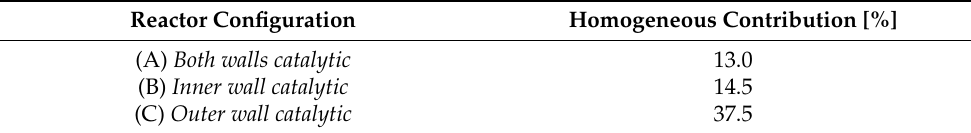
Table 1. Homogeneous contribution to the conversion of propane (Equation (1)) for the three reactor configurations of Figure 1 with different catalyst placement. Low thermal conductivity (3 W/(m K)) and V in = 0.5 m/s.